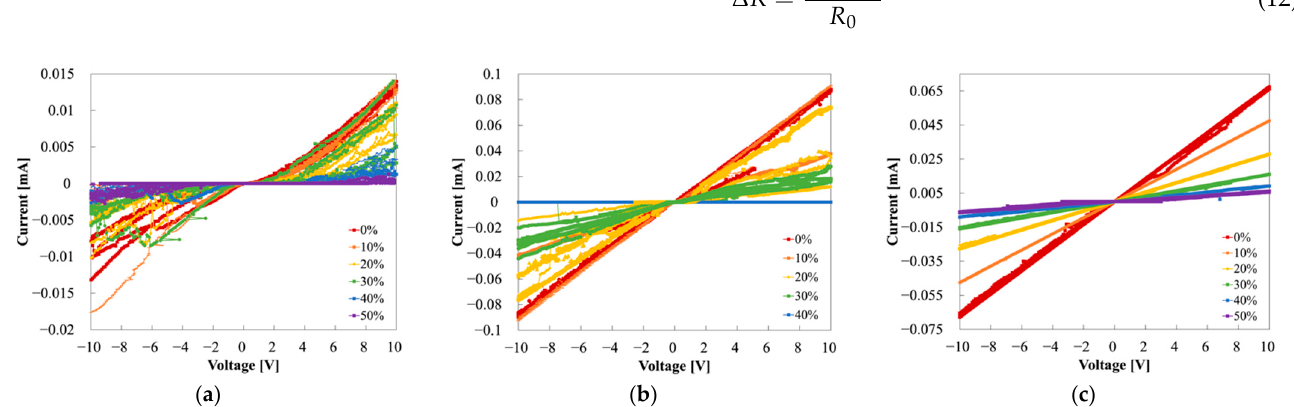
Figure 7. I − V measurement of Samples A–C: ( a ) Sample A (PANI strain sensor), ( b ) Sample B (PANI/Au strain sensor), and ( c ) Sample C (PANI/Au/H-PDMS strain sensor).